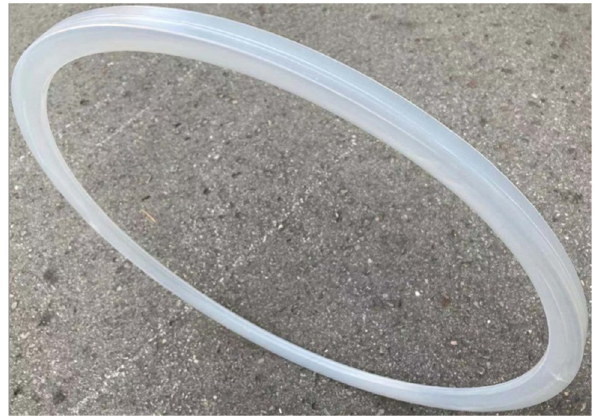
Figure 4: Actual image of the annular axis mandrel.